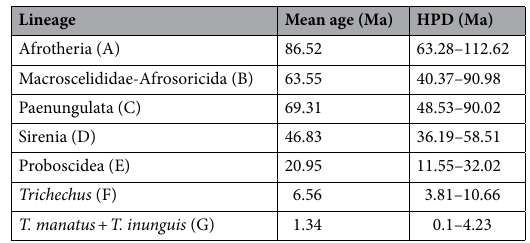
Table 2. The values for lineages divergence, the mean ages and 95% highest posterior density range (HPD).